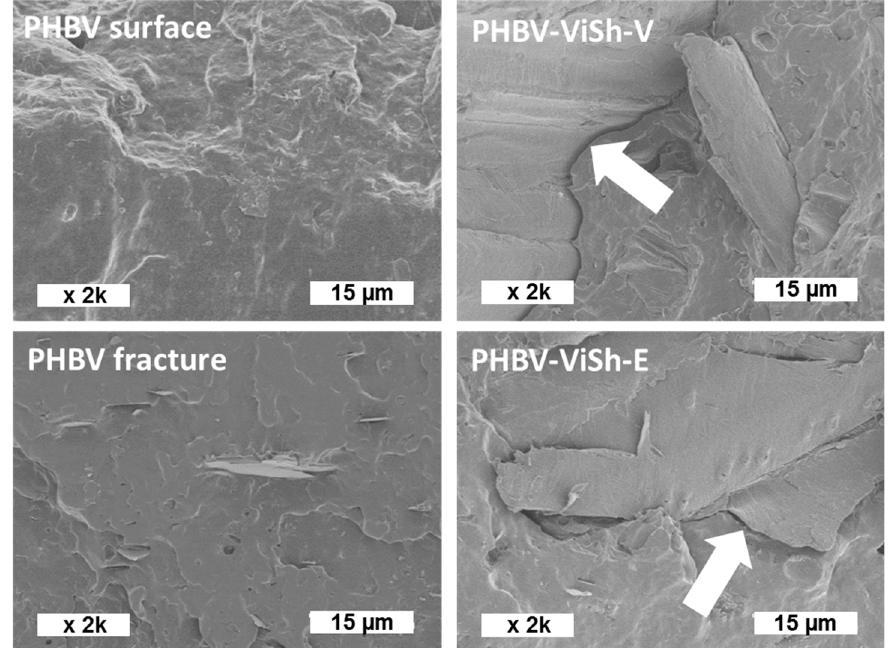
Figure 4. SEM pictures of the poly(3-hydroxybutyrate-3-hydroxyvalerate) (PHBV) surface and fracture (on the left) and SEM pictures of the PHBV-based composite fractures (filler content of 20 wt %) (on the right). White arrows show the matrix/filler interface.